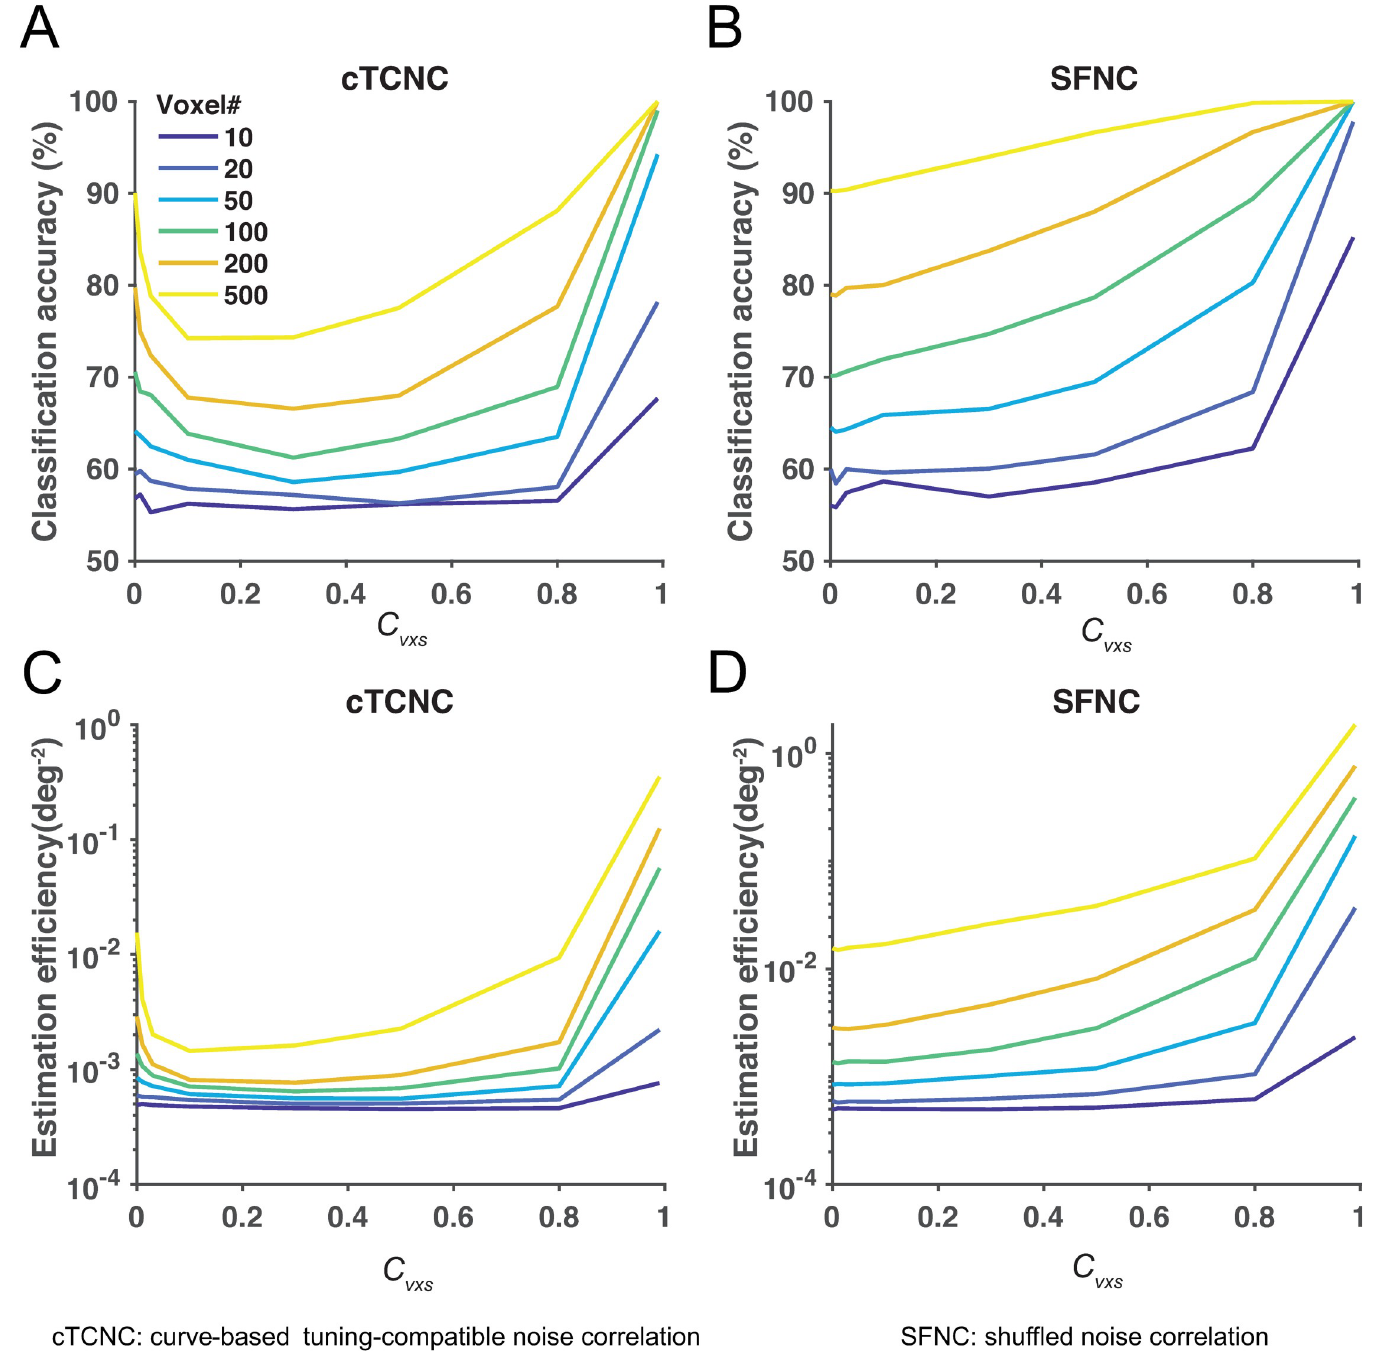
Fig 5. Decoding accuracy as U-shaped functions of cTCNCs in a voxel population. The multivariate classification accuracy (panels A, B) and estimation efficiency (panels C, D) are depicted as a function of the magnitude of cTCNCs (panels A, C) and SFNCs (panels B, D). Decoding accuracy exhibits U-shaped functions as cTCNCs increase. Similar to a neuronal population, SFNCs always improve decoding